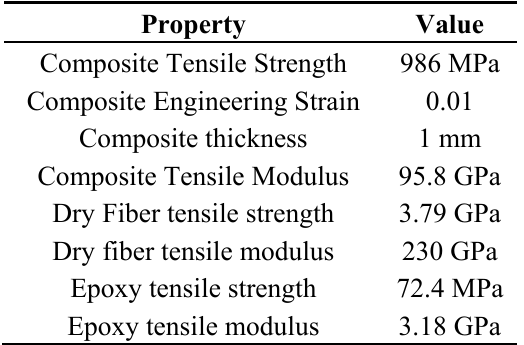
Table 1. Composite Gross Laminate Properties